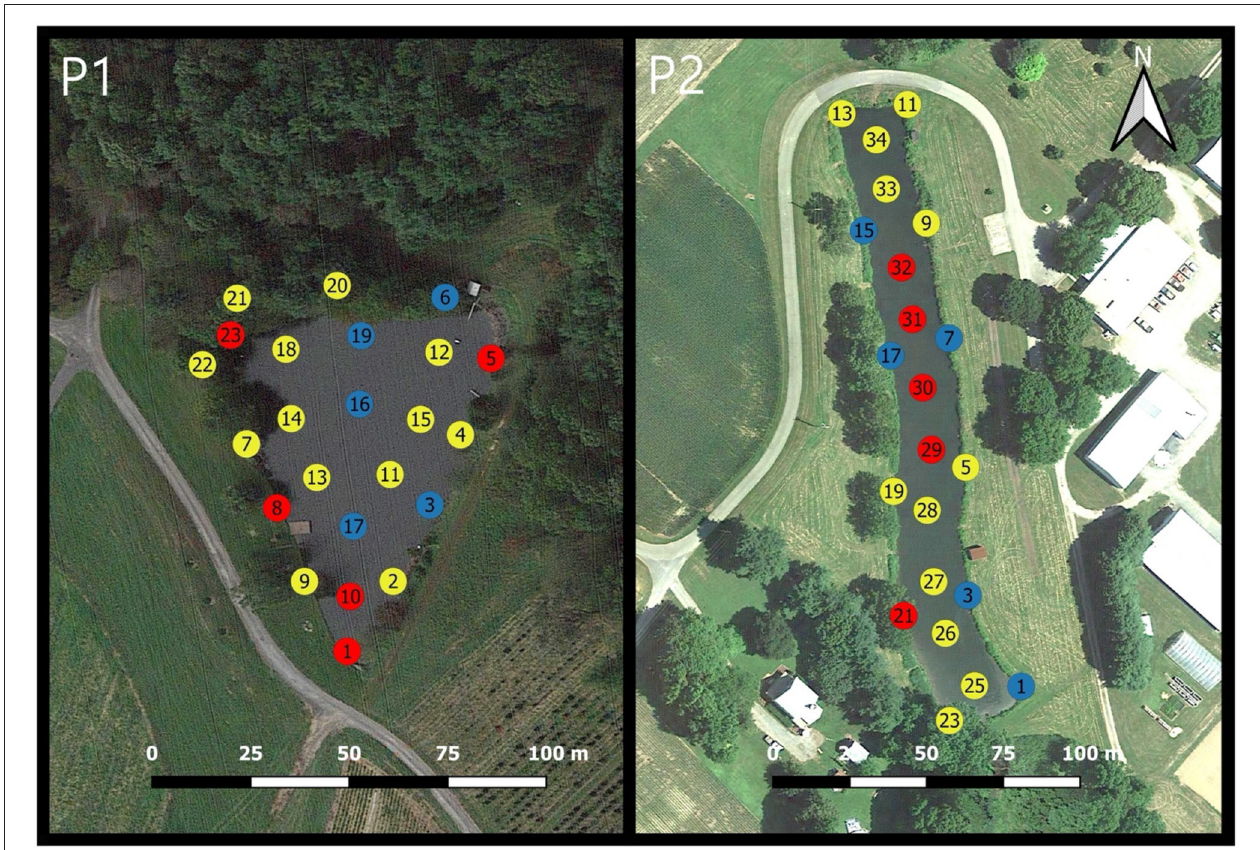
FIGURE 4 | Mean relative differences (MRD) of green algae over the 2-year period for Pond 1 (P1) and Pond 2 (P2). Locations with MRD values below the 25th percentile are displayed in blue, locations above the 75th percentile are displayed in red, and locations between the 25 and 75th percentile are displayed in